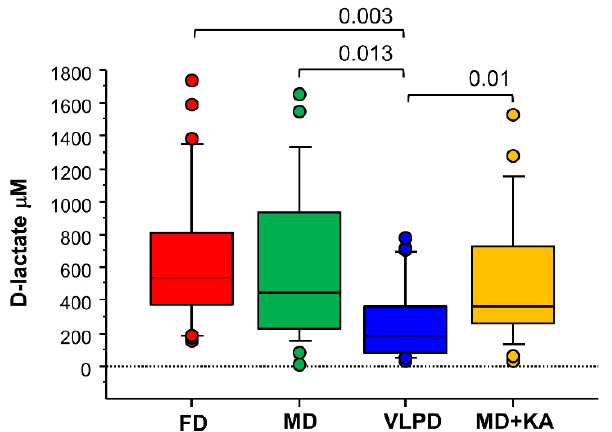
Figure 5. D-lactate serum levels measured in CKD patients in accordance with the different diets (Wilcoxon test).